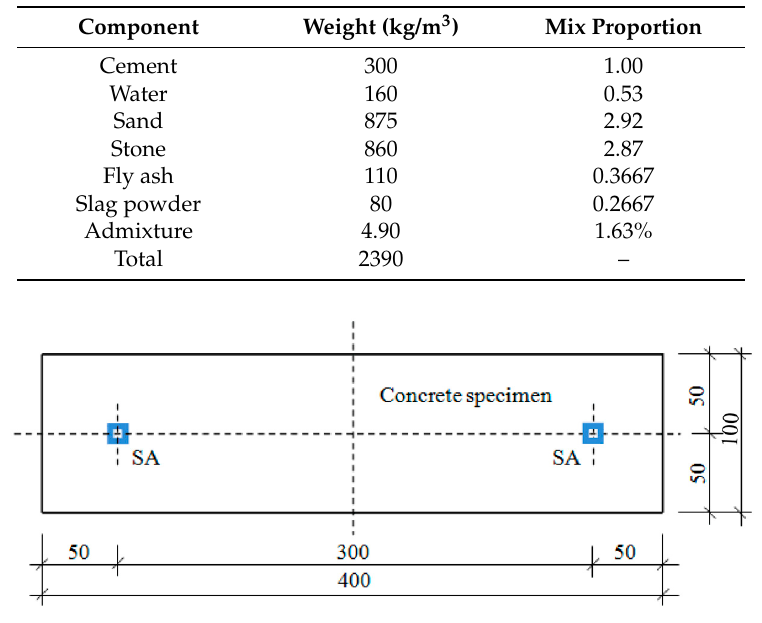
Figure 2. Locations of SA’s (mm). Table 2. Cubic compressive strength of concrete versus age.